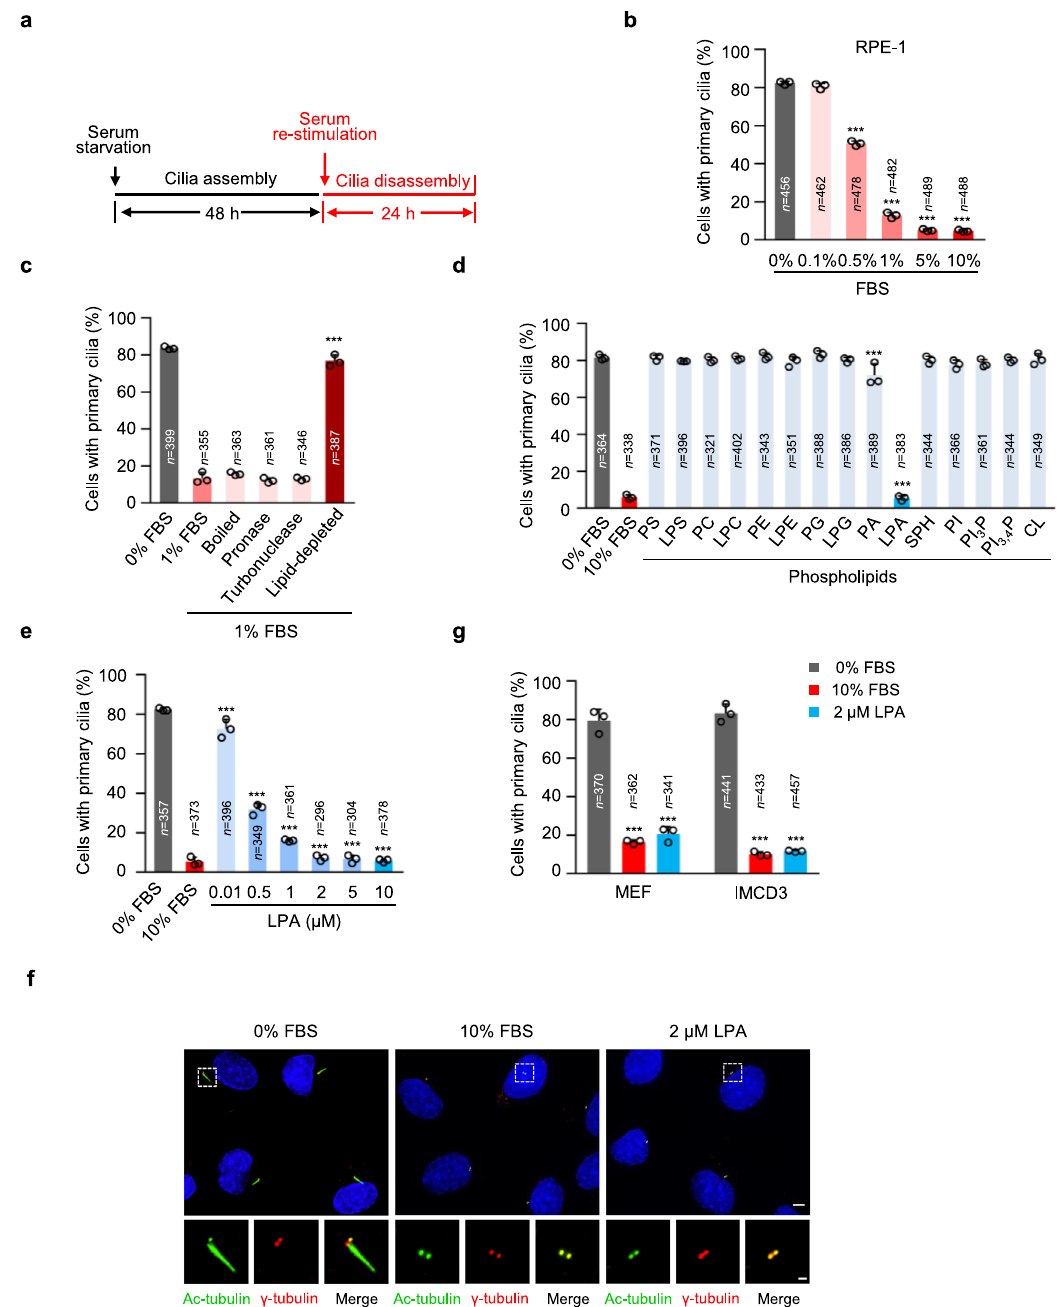
Fig. 1 Identi fi cation of LPA as the major cilia disassembly factor in serum. a Diagram indicates the timing of serum starvation (cilia assembly) and re-stimulation (cilia disassembly). b Serum induces cilia disassembly in a dose-dependent manner. Human retinal pigment epithelial (RPE-1) cells were starved in DMEM/F12 for 48 h to induce cilia formation, and then ciliated RPE-1 cells were re-stimulated with indicated concentrations of FBS for 24 h to induce cilia disassembly. c Lipids are responsible for serum-induced cilia disassembly. Ciliated RPE-1 cells (serum-starved) were stimulated with 1% boiled, pronase-pretreated, turbonuclease-pretreated or lipid-depleted serum for 24 h, respectively. d Lysophosphatidic acid (LPA) induces cilia disassembly. Ciliated RPE-1 cells (serum-starved) were stimulated with 100 μ M of various phospholipids for 24 h. Full name of lipids used are shown in “ Methods. ” e Dose-dependent effects of LPA on cilia disassembly. Ciliated RPE-1 cells (serum-starved) were treated with different concentrations of LPA for 24 h. f Representative images of RPE-1 cells in ( e ). Cells were stained with anti-Ac-tubulin (green) and anti- γ -tubulin (red) antibodies. Scale bar, 5 μ m (main image) and 1 μ m (magni fi ed region). Three experiments were repeated independently with similar results. g LPA treatment (2 μ M for 24 h) induces cilia disassembly in primary MEF and IMCD3 cells. Source data are provided as a Source Data fi le. Data are presented as mean ± S.D. of three independent experiments in ( b – e ) and ( g ). n , number of cells. *** P < 0.001. One-way ANOVA test was performed followed by Dunnett ’ s multiple comparisons in b – e ; two-way ANOVA test was performed in followed by Dunnett ’ s multiple comparisons in g .